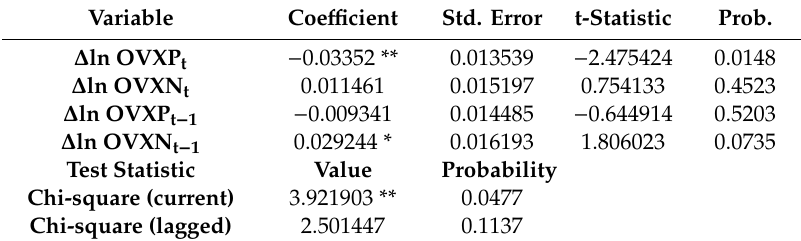
Table 26. Regression results for positive and negative oil price volatility